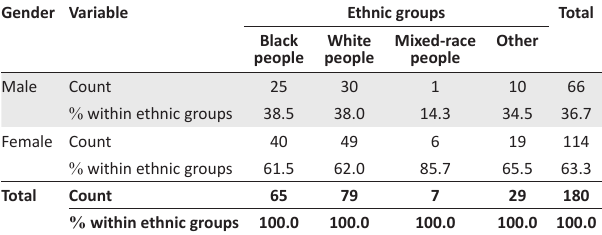
TABLE 1: Demographic profile of the respondents. Gender